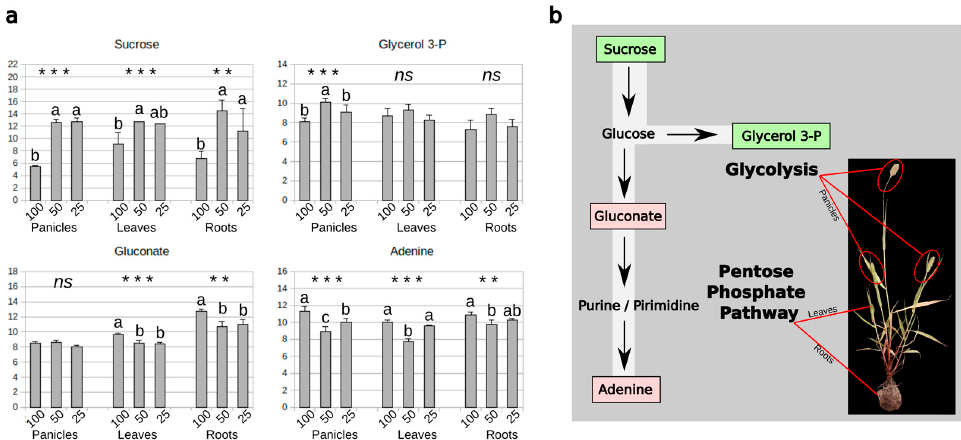
Figure 4. Water-limitation-responsive metabolites shared by S. viridis panicles, leaves and roots. These metabolites correspond to the common area of Venn diagram shown in Figure 3. ( a ) Results of ANOVA analysis. Different letters indicate significant differences ( p < 0.05) between the water treatments in the same plant organ. Asterisks indicate the significant effects in each plant organ (** p ≤ 0.01; *** p ≤ 0.001); ns = not significant. ( b ) Proposed model of pathways connecting the shared metabolites. Along the X axis, the numbers 100, 50, 25 refer to the water treatments. Water limitation increased sucrose levels in above- and underground parts of S. viridis